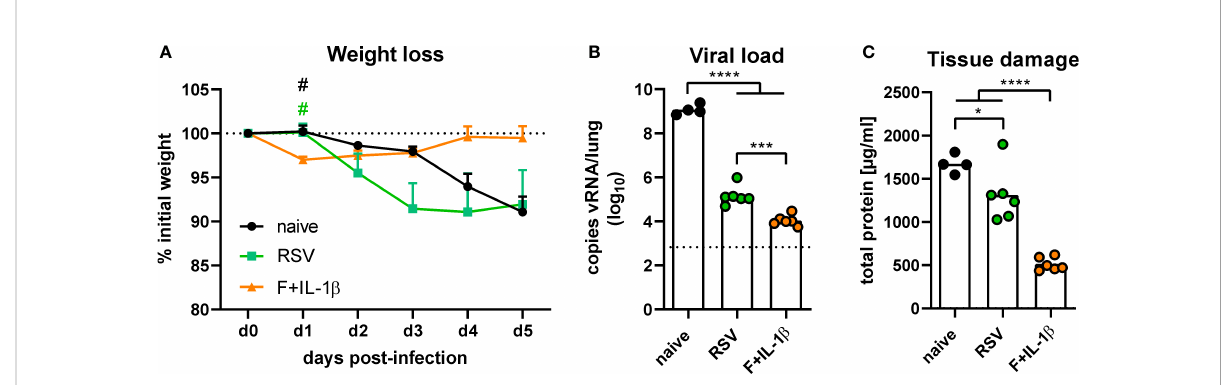
FIGURE 7 Protection against RSV infection mediated by vaccination and a primary RSV infection. Mice were experimentally infected with 1x10 6 PFU RSV- A2 48 days after the immunization or primary infection. (A) The initial weight was set as 100% (dotted line) and weight changes were monitored for fi ve days. (B) Viral RNA copies were quanti fi ed by qRT-PCR in lung homogenates fi ve days post-infection. The dotted line represents the lower limit of quanti fi cation. (C) Tissue damage was assessed by measuring the total concentration of protein in BAL samples via bicinchoninic acid assay. Data represent group means with SEM (A) , group medians overlaid with individual data points (B) , or group means overlaid with individual data points (C) . n=4-6. Data were analyzed by one-way ANOVA followed by Tukey´s post test (values in B were log-transformed before analysis). For (A) : # p <0.05 vs . F+IL-1 b . For (B, C) : * p <0.05, ** p <0.005, *** p <0.0005, **** p